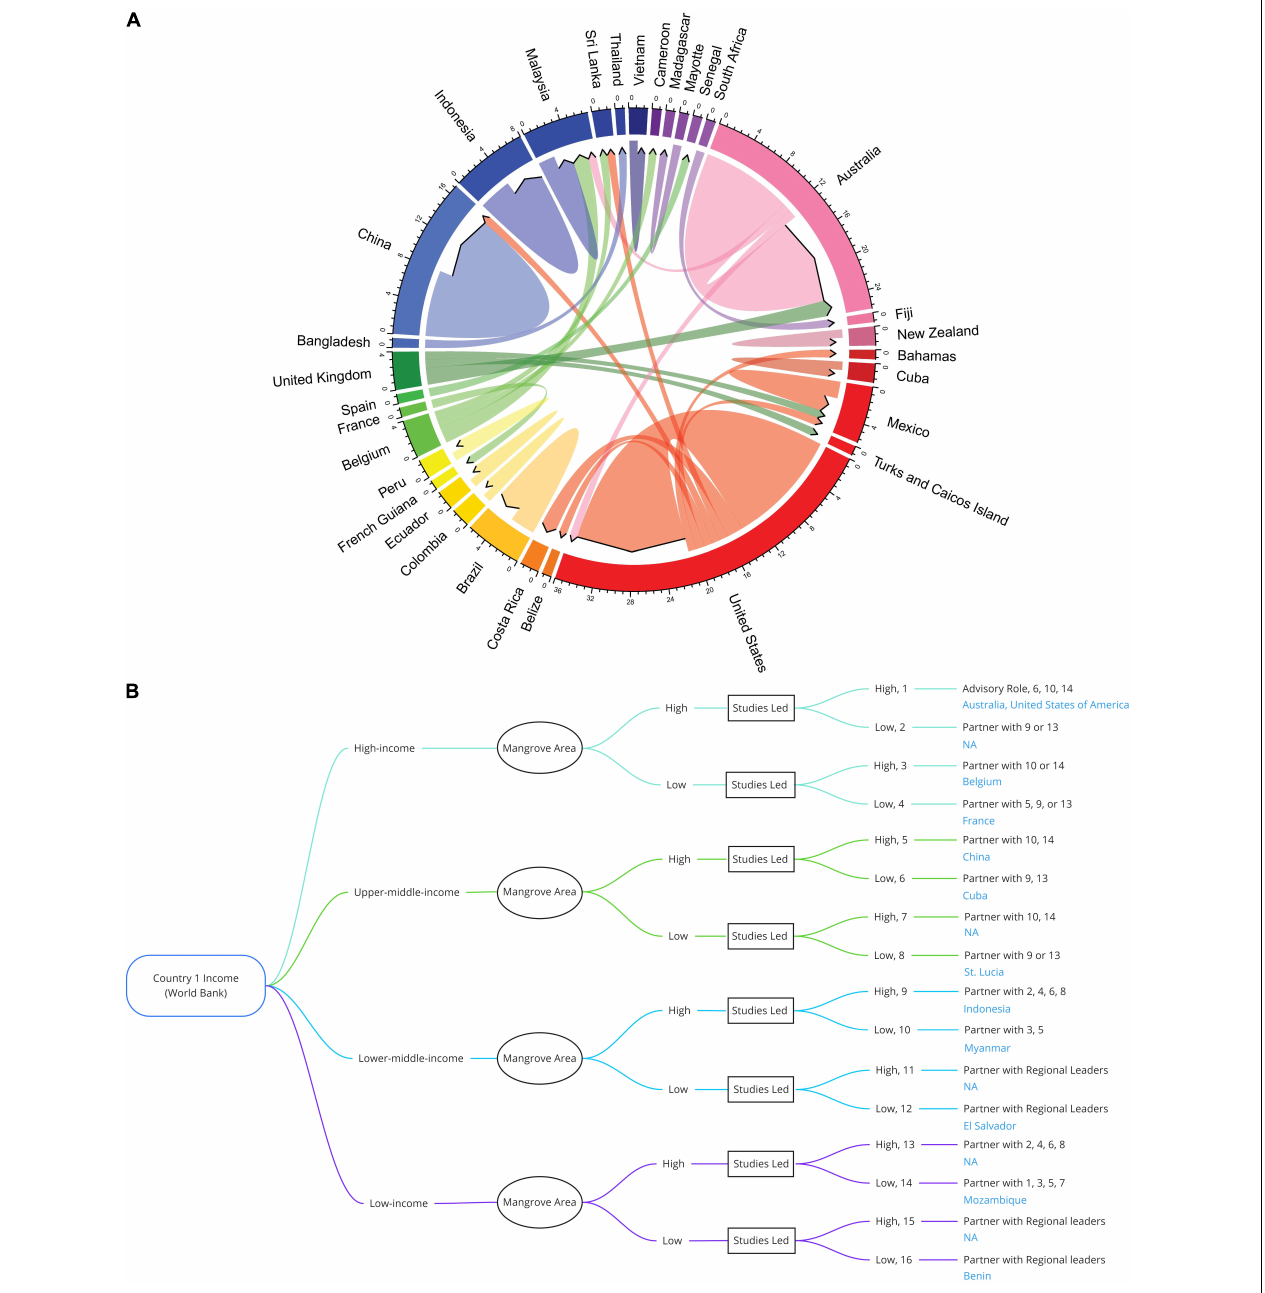
FIGURE 2 | (A) Summary of countries with researchers leading 72 aerial studies, and where those studies are conducted. Continents are represented by the following shades: Asia—blue; Africa—purple; Oceania—pink; North America—red; Central America—yellow; South America—orange; Europe—green. Color of the chord represents the country that is leading the study. Chords leaving the country denote the number of studies led by that country, while black-tipped chords pointing to a country denotes the number of studies that are conducted within that country. (B) Decision-tree of suggested partnerships regarding mangrove monitoring using aerial tools. Thresholds of each step is determined as follows: Country income: Levels determined by World Bank; Mangrove Area: High is top 28 countries in global mangrove coverage, which covers up to 90% of the world’s mangroves, Low is any country outside of this top 15; Studies led: High is four and above (average of the data set), Low is three and below. Example countries are in blue. NA denotes that no example country was